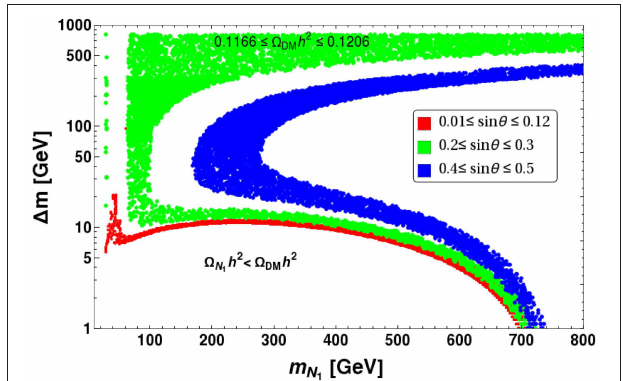
1 m plane for 1 − 0.01 0.12 (Red), 0.2 0.03 (Green), and { − } { − }